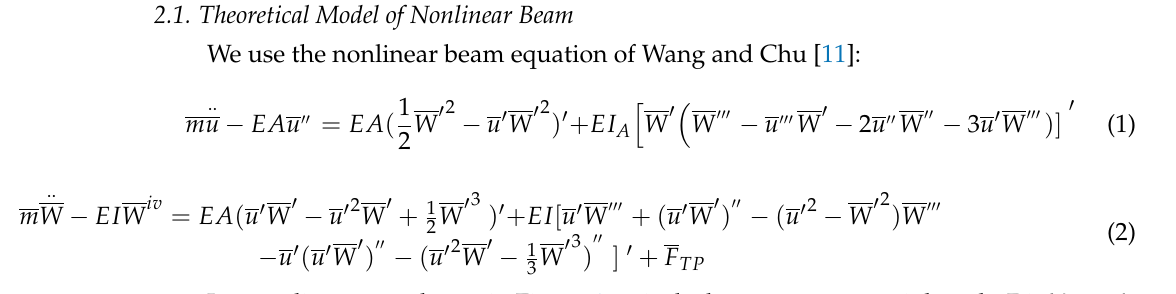
Figure 3. Schematic diagram of the CVEH system.